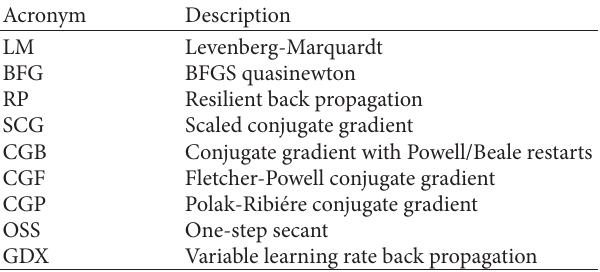
Table 3: The variable training methods.